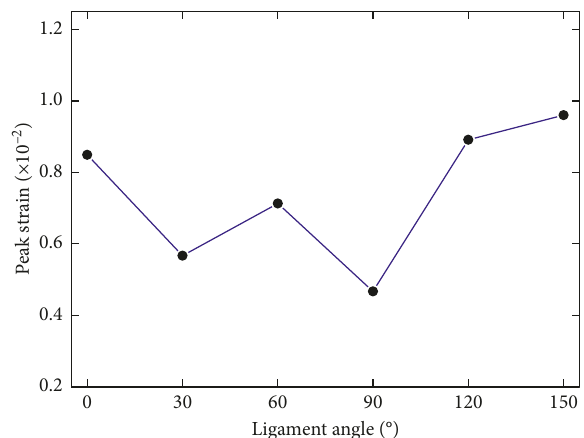
Figure 12: Influence of the ligament angle on the peak strain of specimens with a constant flaw angle of 0 °